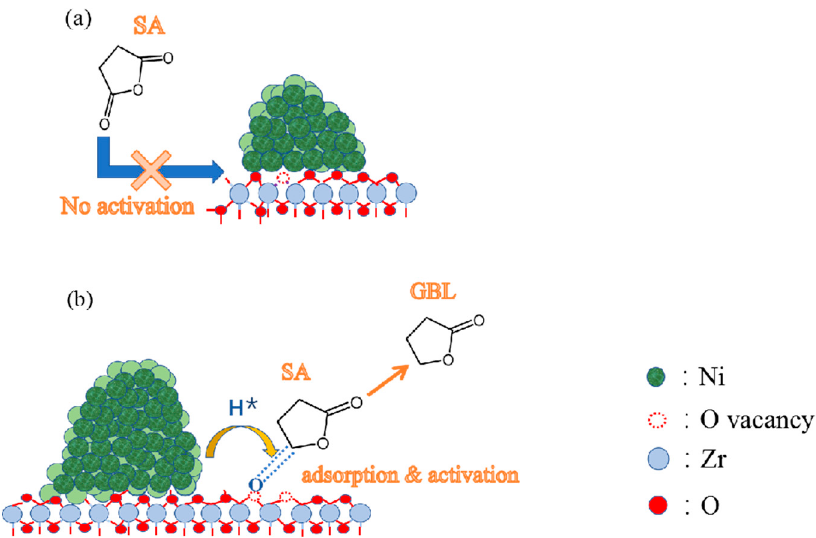
Figure 11. ( a ) Structure of nickel particles on the ZrO 2 (P). ( b ) Structure of nickel particles on the ZrO 2 (H) and hydrogenation of SA on the Ni/ZrO 2 (H). (H) and hydrogenation of SA on the Ni/ZrO 2